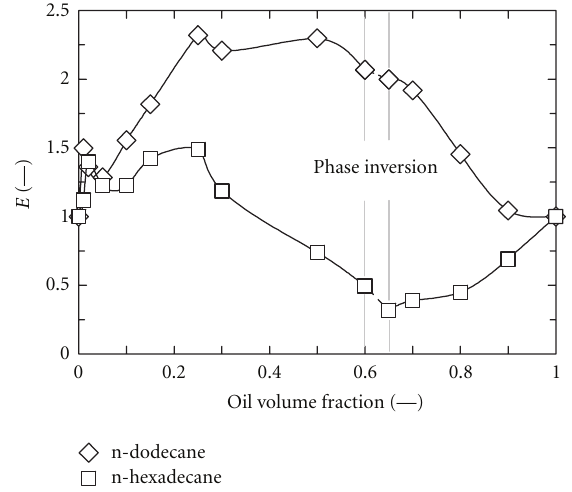
Figure 9: Variation of the mass transfer enhancement factor E with the n-dodecane and the n-hexadecane volume fraction.